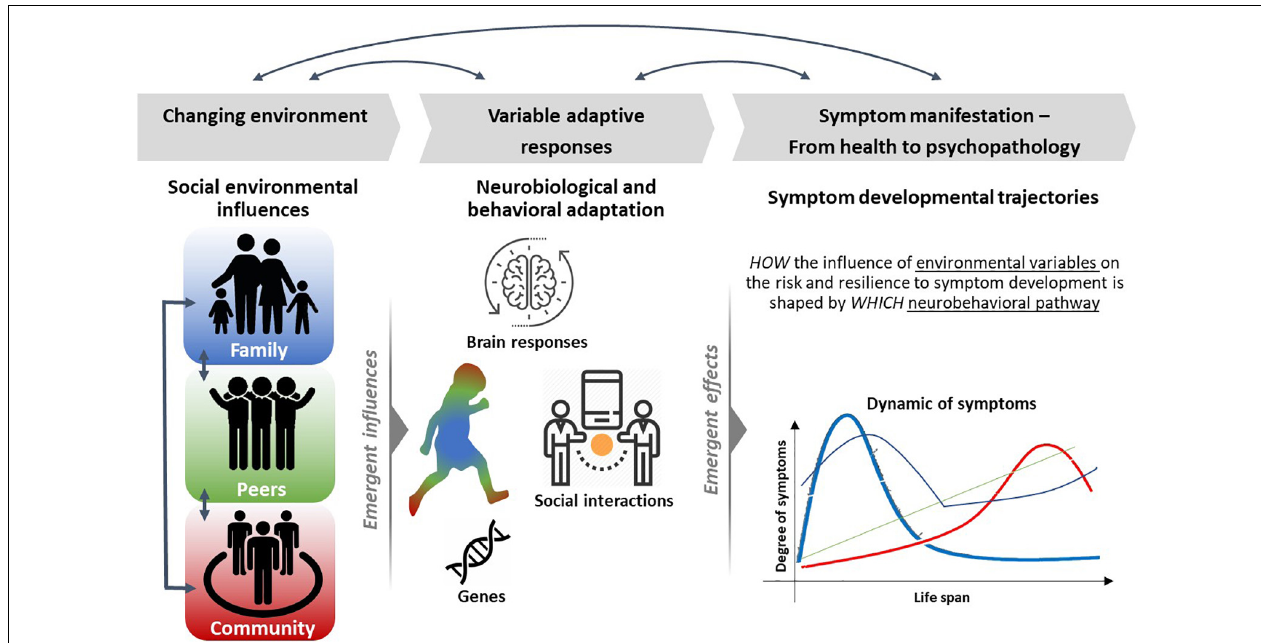
FIGURE 1 | Overview on an integrative and multimodal approach to study how environmental influences dynamically shape risk and resilience on the level of neurobehavioral adaptation at different developmental stages. There are several influences through the social environment ( left ) and individuals differ in their degree to which they are exposed to environmental variation. Such variations may be reflected in neurobiopsychological and behavioral reactivity, for example, through brain–behavior relationships or gene–environmental interactions ( middle ). These variations underlie life-time-dependent changes over time and together represent trajectories of risk into and resilience for maladaptive behavior and psychopathological symptomatologies ( right